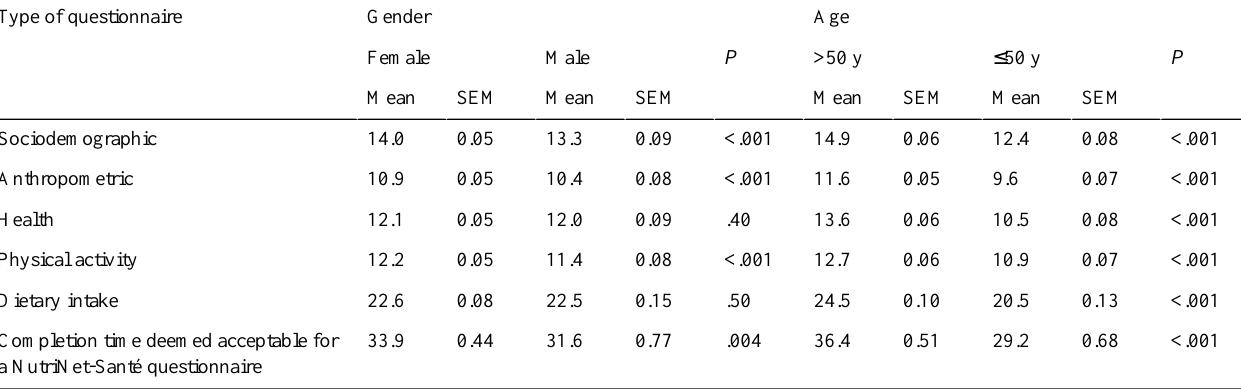
Table 5. Comparison of mean response time for questionnaires (in minutes) according to gender and age, NutriNet-Santé Study, France, 2013. a